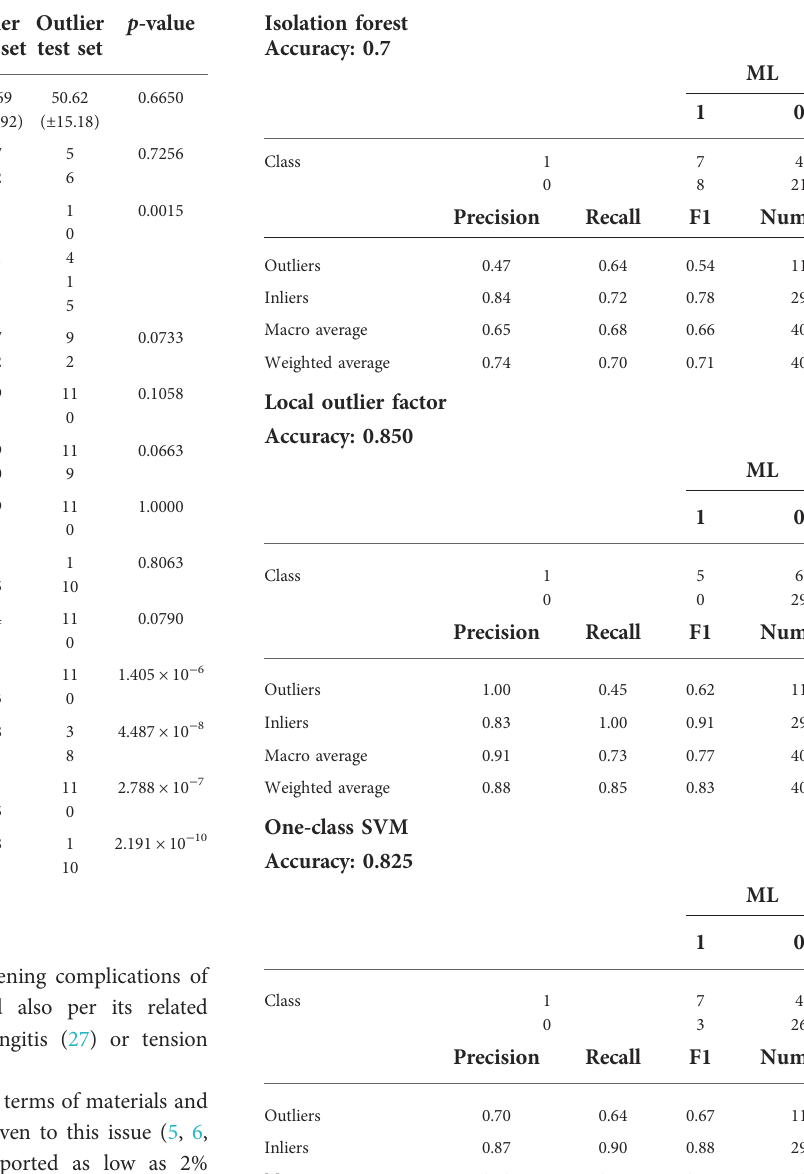
TABLE 1 Patient